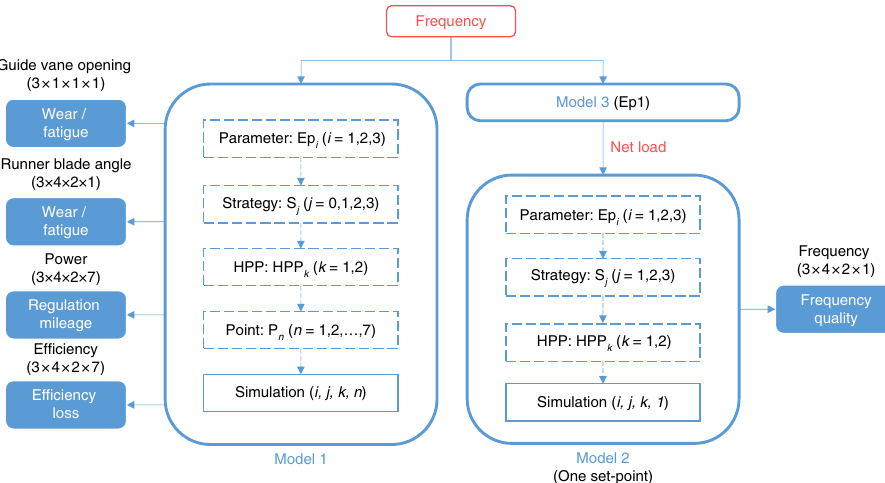
Fig. 2 Illustration of the simulation structure. The models 1 – 3 are introduced in Methods and Supplementary Note 3. The blocks with dashed outline represent the selections in simulation setting based on different conditions: i varies from 1 – 3, for three sets of governor parameters Ep1 – Ep3; j varies from 1 to 4, for three regulation strategies (S1 – S3) and an ideal on-cam case (S0); k varies from 1 to 2 for two HPPs; n varies from 1 to 7 for seven operating set- points. The set in the parenthesis with simulation presents different cases conducted in the model. In total, there are 168 (3 × 4 × 2 × 7) and 24 (3 × 4 × 2 × 1) simulation cases conducted in Model 1 and Model 2, respectively. The products in the parenthesis with the output variables show the actual needed set of results for analyzing the corresponding indicator in this